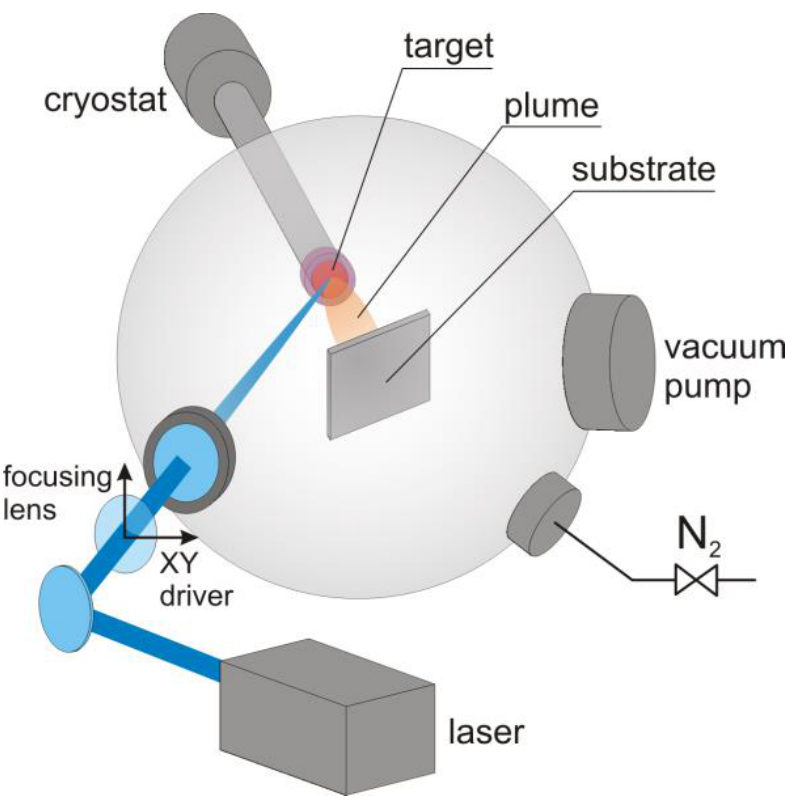
Figure 1. Schematic view of the MAPLE deposition setup.